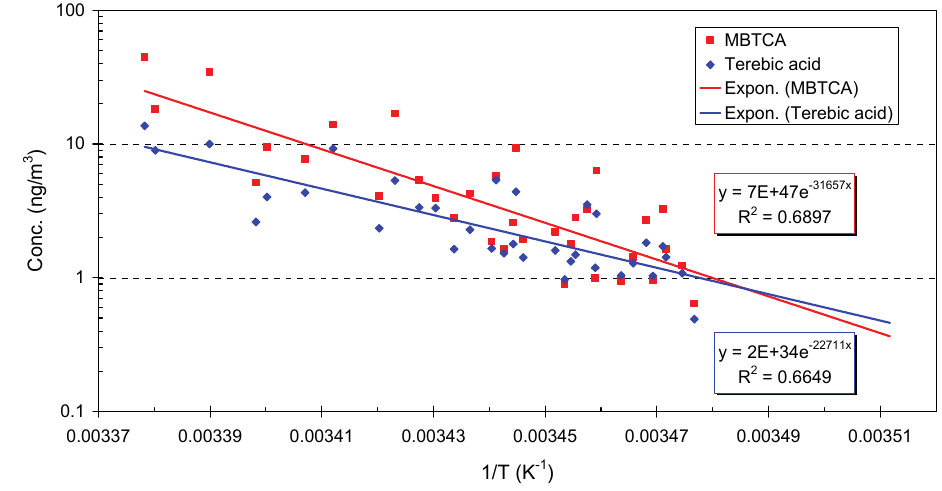
Figure 6. Arrhenius-type temperature dependencies observed for α -pinene oxidation products: mass concentrations of 3-MBTCA and terebic acid in PM2.5 plotted against inverse absolute temperature. The data points represent individual day-time samples (N = 34) and the full lines are exponential fits. The corresponding Arrhenius parameters for MBTCA are: A (pre-exponential factor) = 7.0 x 10 47 ng/m 3 and E a = 260 ± 30 kJ/mol; those for terebic acid are: A = 2.0 x 10 34 ng/m 3 and E a = 189 ± 24 kJ/mol.